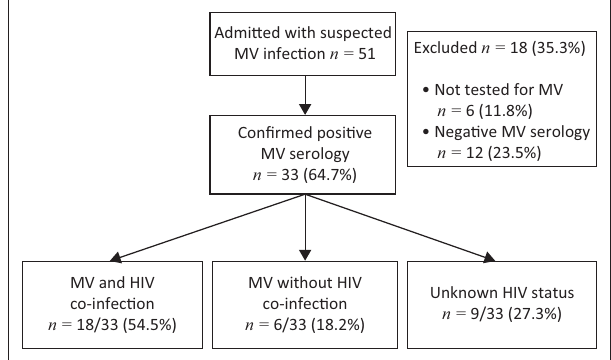
FIGURE 1: Flow diagram of the study